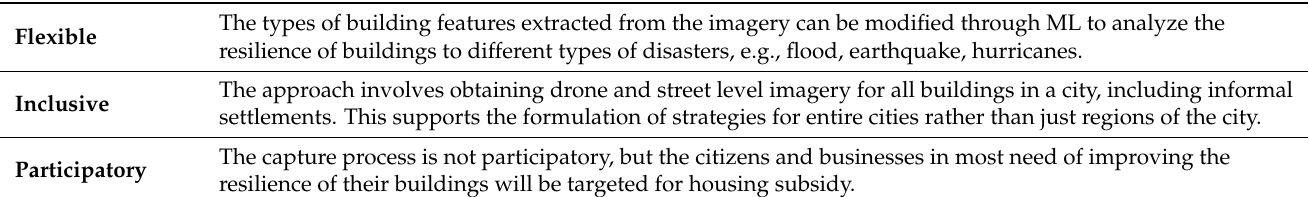
Table 6. FFP Approach Compliance Check.